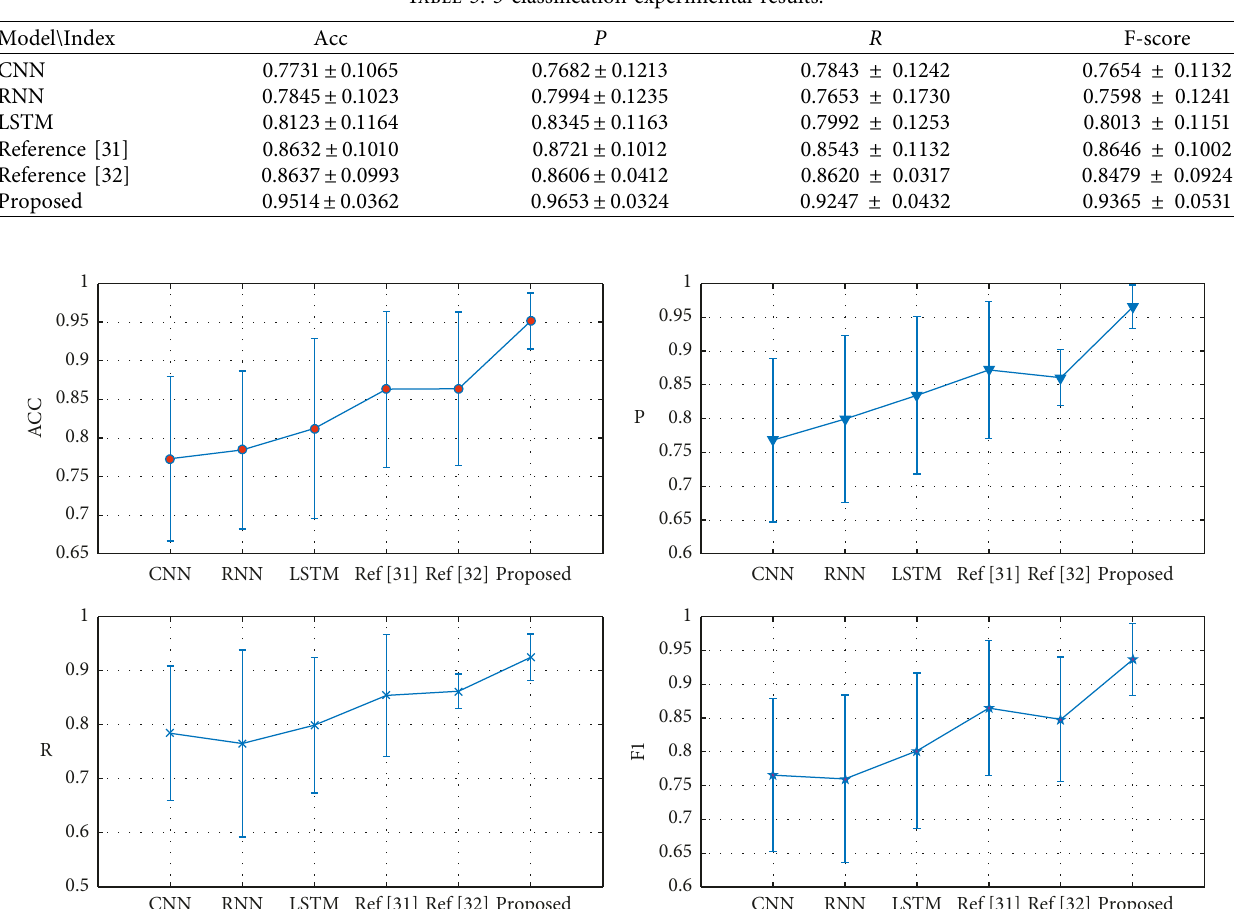
Table 5: 3-classification experimental results.